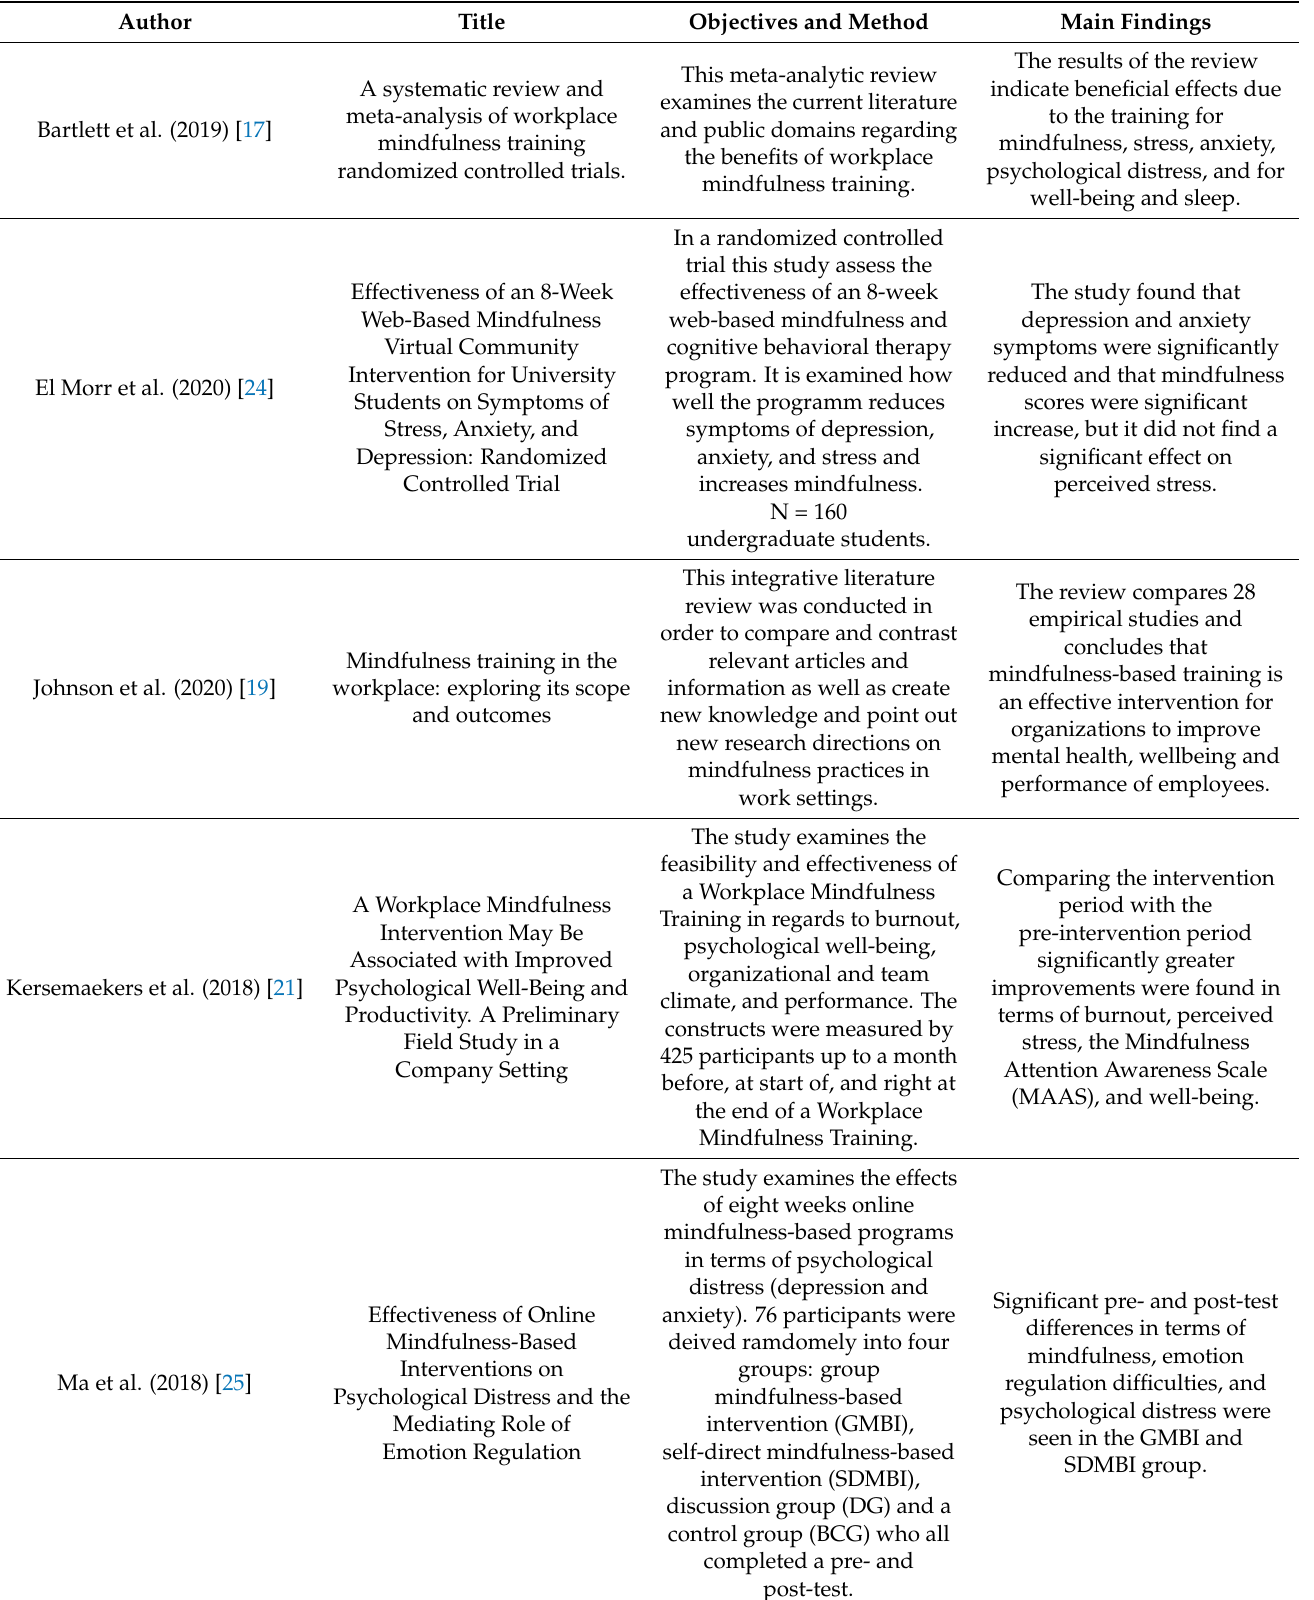
Table 1. Comprehensive overview of the recent literature on mindfulness